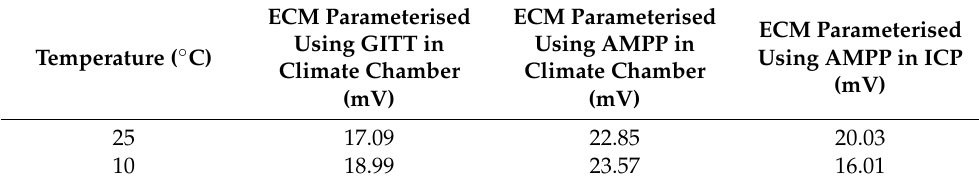
Table 3. Voltage RMS error in the model relative to the drive cycle experimental